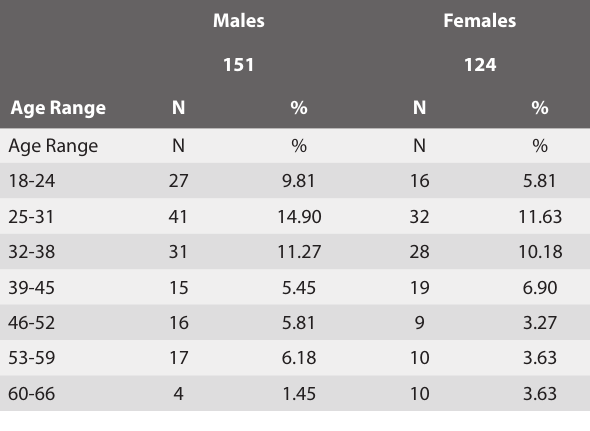
Table 1. SARS-CoV-2 sampled population. Distribution by gender and